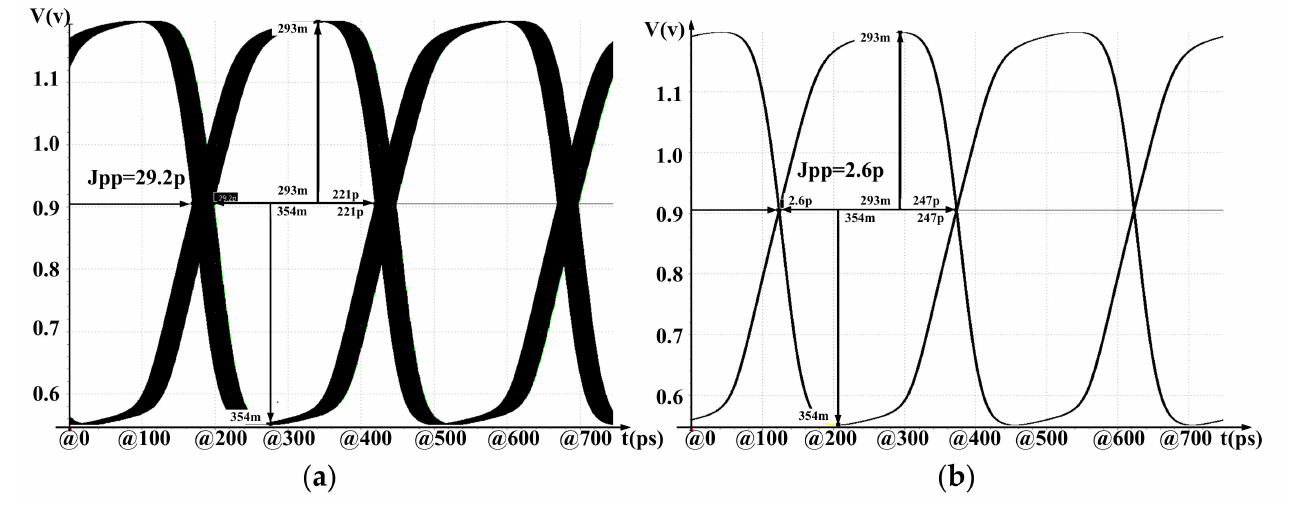
Figure 11. The eye diagram of the 2GHz VCO output ( a ) without calibration; ( b ) with